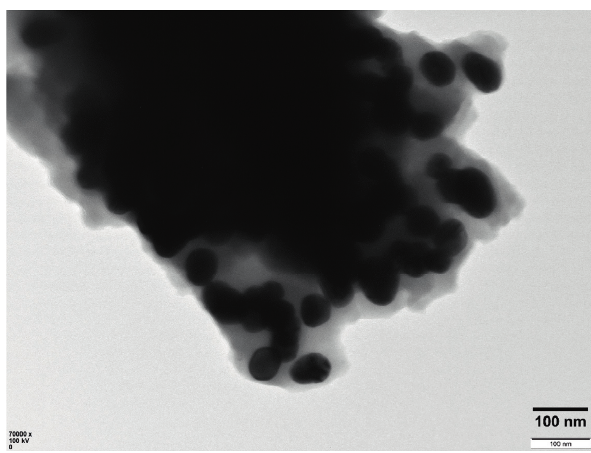
Figure 5: TEM micrograph of NiO-ZnO NC.